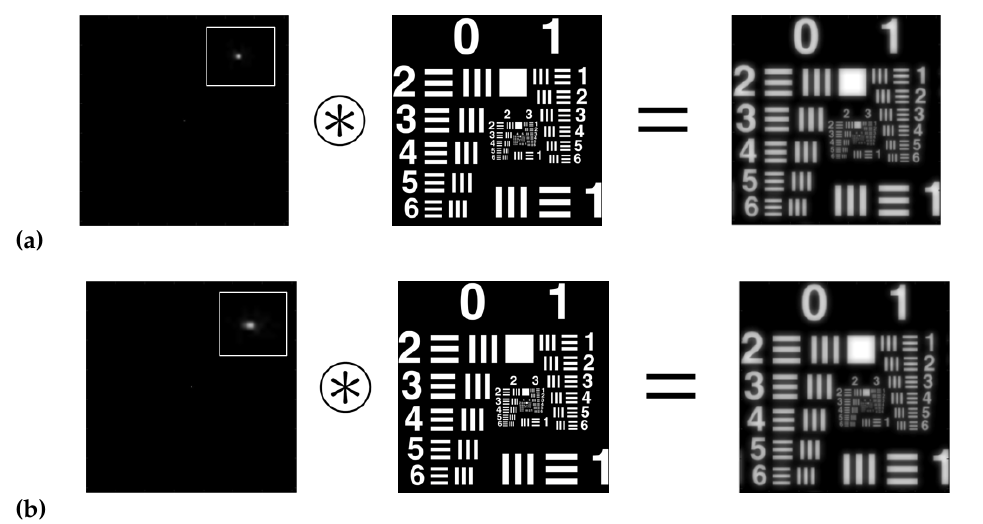
Figure 5. Simulated convolution for negative asymmetrical HLs, with ASF obtained with the HS wavefront sensor, reconstructed at ( a ) 473 nm and ( b ) 633 nm.